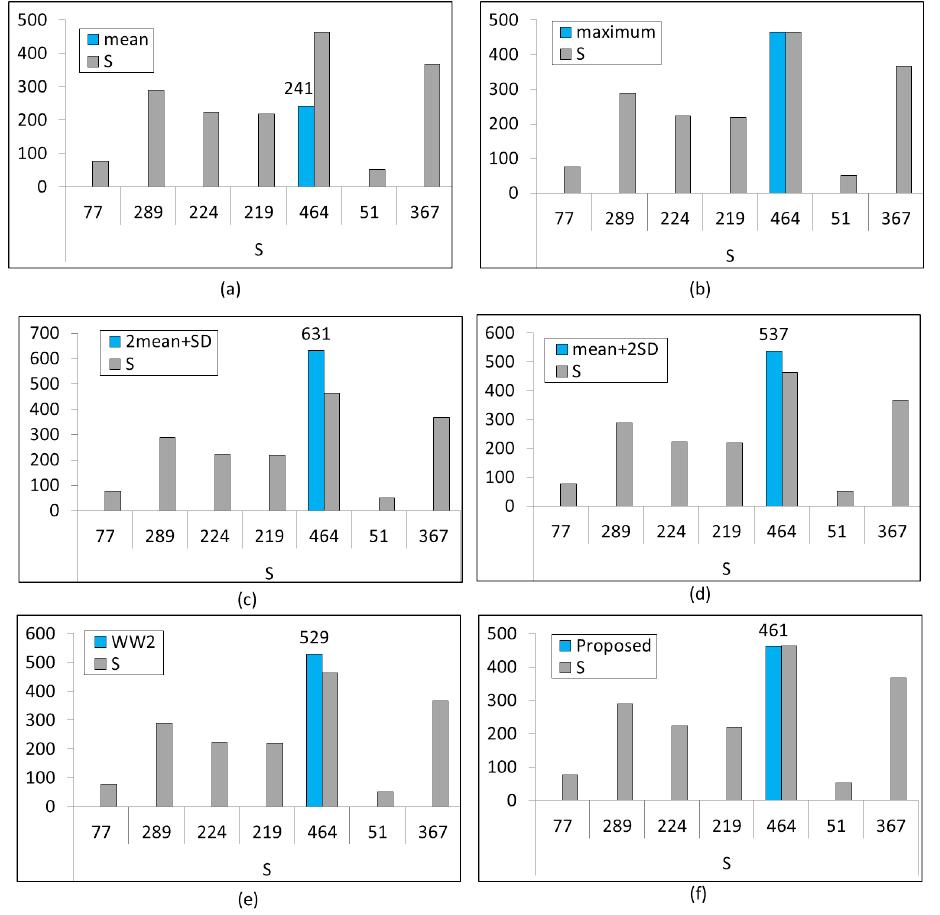
Figure 2. Output of various types of sample statistics for S , given in (1). ( a ): mean plot. ( b ): maximum plot. ( c ): 2 × mean + SD plot. ( d ): mean + 2 × SD plot. ( e ): WW2 plot. ( f ): Proposed algorithm plot.